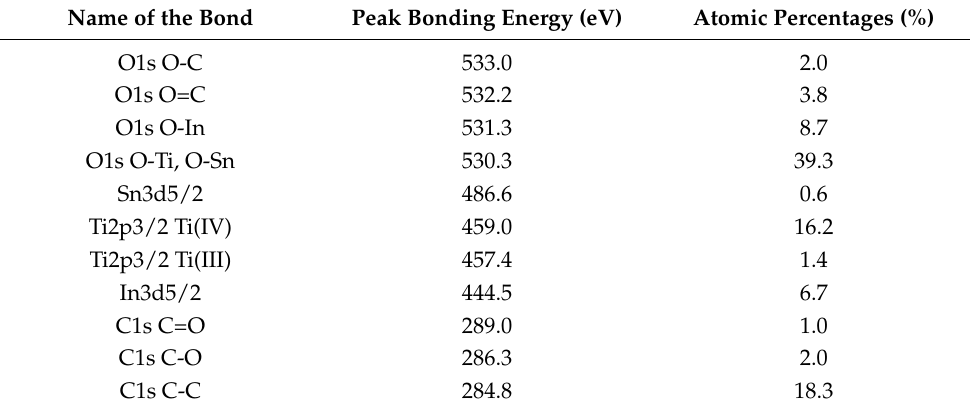
Table 3. Peaks bonding energy and atomic percentages from